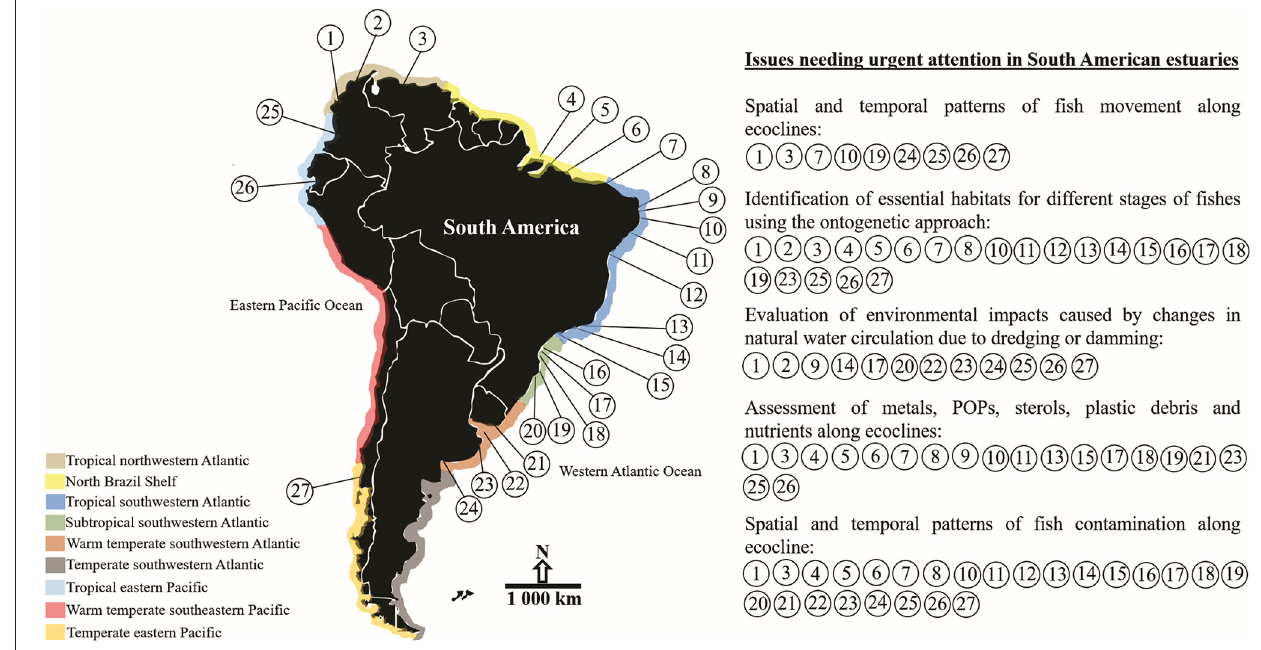
FIGURE 1 | Location and main conservation issues identified in South American estuaries. Tropical northwestern Atlantic [(1) Atrato River Delta; (2) Ciénaga Grande de Santa Marta Lagoon; (3) Orinoco River Delta]. North Brazil Shelf [(4) Amazon Estuarine Complex; (5) Curuçá Estuary; (6) Caeté Estuary]. Tropical southwestern Atlantic [(7) Parnaiba River Delta; (8) Potengi Estuary; (9) Goiana Estuary; (10) Itamaracá Estuarine System; (11) São Francisco River Estuary; (12) Paraguaçu Estuary; (13) Guanabara Bay; (14) Sepetiba Bay; (15) Santos Estuary]. Subtropical southwestern Atlantic [(16) Paranaguá Estuarine Complex; (17) Guaratuba Bay; (18) Babitonga Bay; (19) Laguna Estuarine Complex; (20) Patos Lagoon Estuary]. Warm temperate southwestern Atlantic [(21) Pando Sub-Estuary; (22) Río de La Plata Estuary; (23) Mar Chiquita Coastal Lagoon; (24) Bahía Blanca Estuary]. Tropical eastern Pacific [(25) Bahía Málaga Estuary; (26) Rio Palmar and Rio Javita Estuaries]. Temperate eastern Pacific [(27) Valdivia Estuary]. Source: Google Earth.